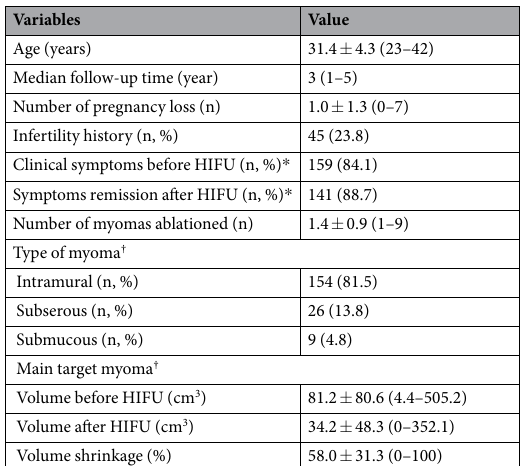
Table 1. Patient Characteristics of 189 women. * Whether clinical symptoms were relieved according to the patient’s subjective evaluation. † In cases of multiple myomas, these findings refer to only the largest myoma.